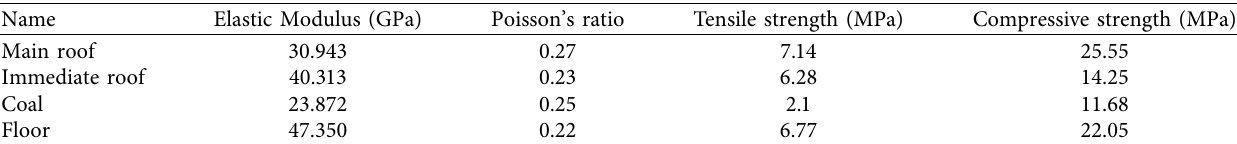
Table 1: Physical and mechanical parameters of coal and rock.